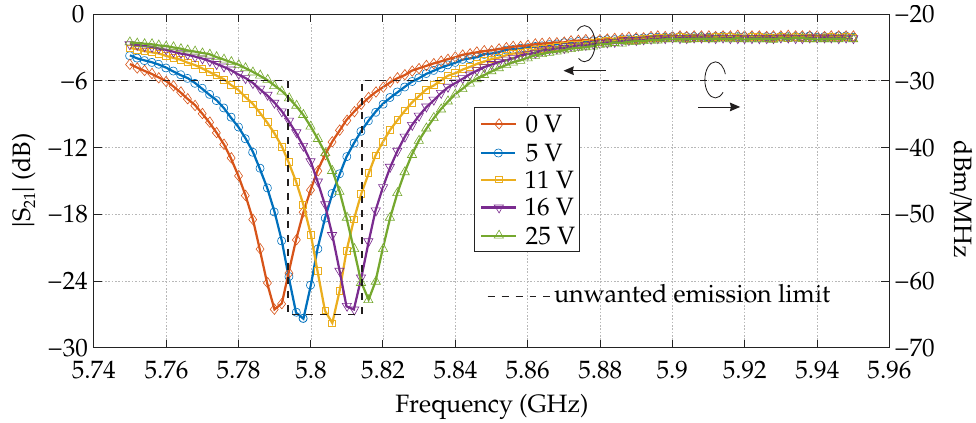
Figure 5. Frequency response of the filter as a function of control voltage V r